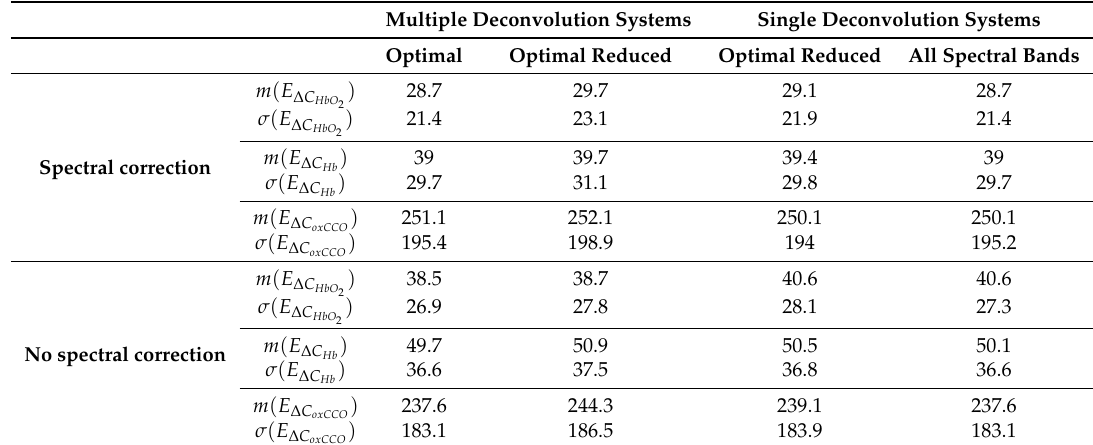
Table 3. Quantification performances of the multiple and single deconvolution systems of the hyperspectral